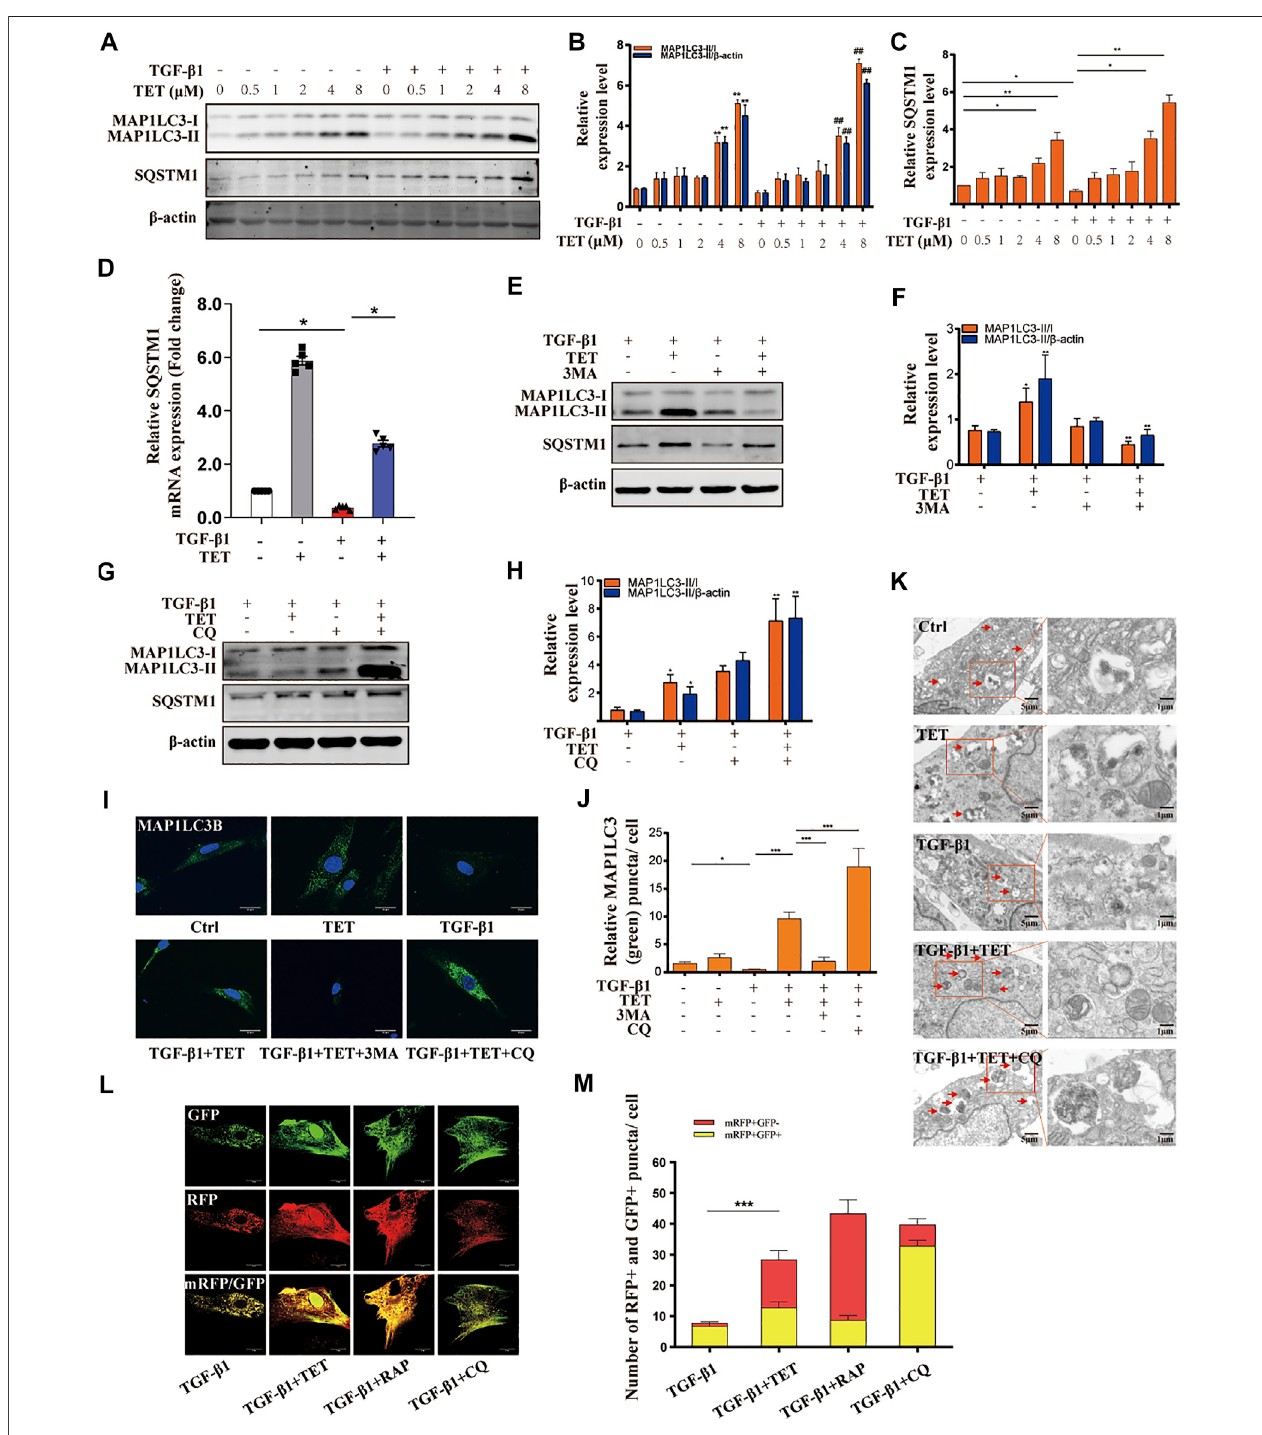
FIGURE3| TETrestoresTGF- β 1-inducedimpaired autophagyinprimaryMLFs. (A-C) PrimaryMLFswerepretreatedwithTETforindicatedconcentrationsfor1 h and then subsequently stimulated with or without TGF- β 1 (10 ng/ml) for 24 h. Representative immunoblot analysis (A) and quantitative analysis (B – C) showed the expression of autophagy (MAP1LC3-I/II, SQSTM1) markers and β -actin (loading control). Values in bar graph are presented as means ± SEM (n (cid:2) 5). Two-way ANOVA: * p < 0.05, ** p < 0.01, versus the control group; # p < 0.05, ## p < 0.01, versus the TGF- β 1 group. (D) Primary MLFs were pretreated with DMSO or TET (4 μ M) for 1 h and stimulated with or without TGF- β 1 (10 ng/ml) for 24 h. Representative of qPCR analysis showed the mRNA expression of SQSTM1. (E,F) Primary MLFs were exposed to TGF- β 1(10 ng/ml) for 24 h. In some experimental groups, cells were treated with TET (4 μ M), 3-methyladenine (3 MA: 500 nM). Immunoblot assays (E) and densitometric analysis (F) showed the expression of autophagic markers. (G,H) Primary MLFs were treated with TGF- β 1 (10 ng/ml) in the presence/absence of TET